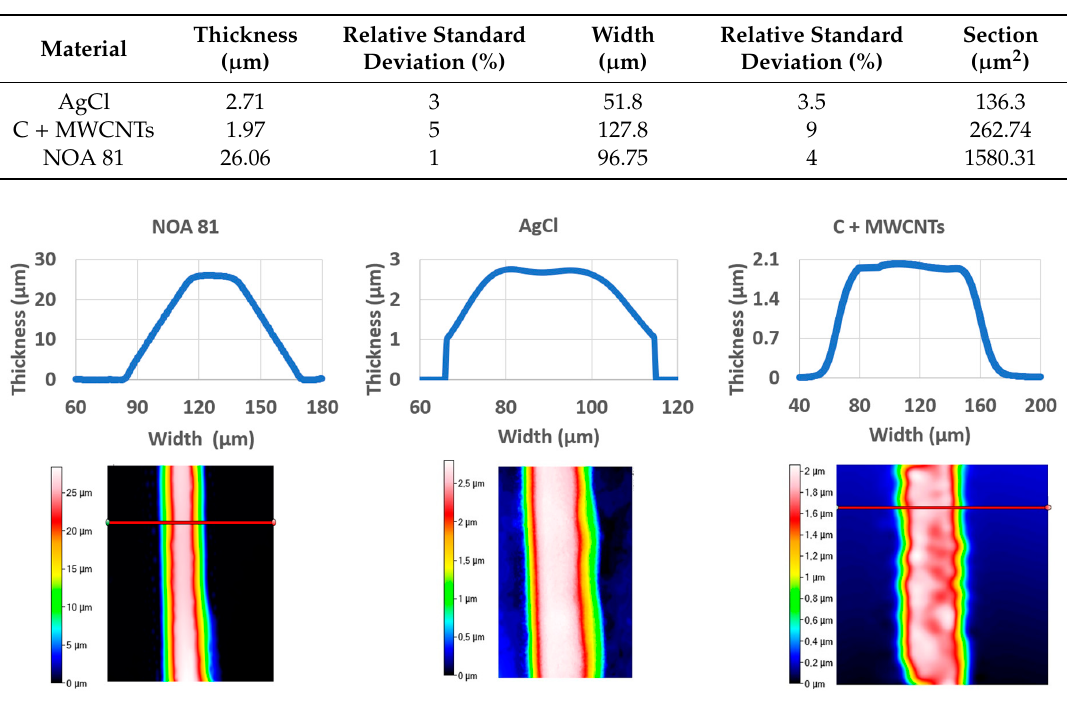
Figure 7. Profiles obtained thanks to Filmetrics 3D optical profilometer for NOA 81, carbon with MWCNTs and